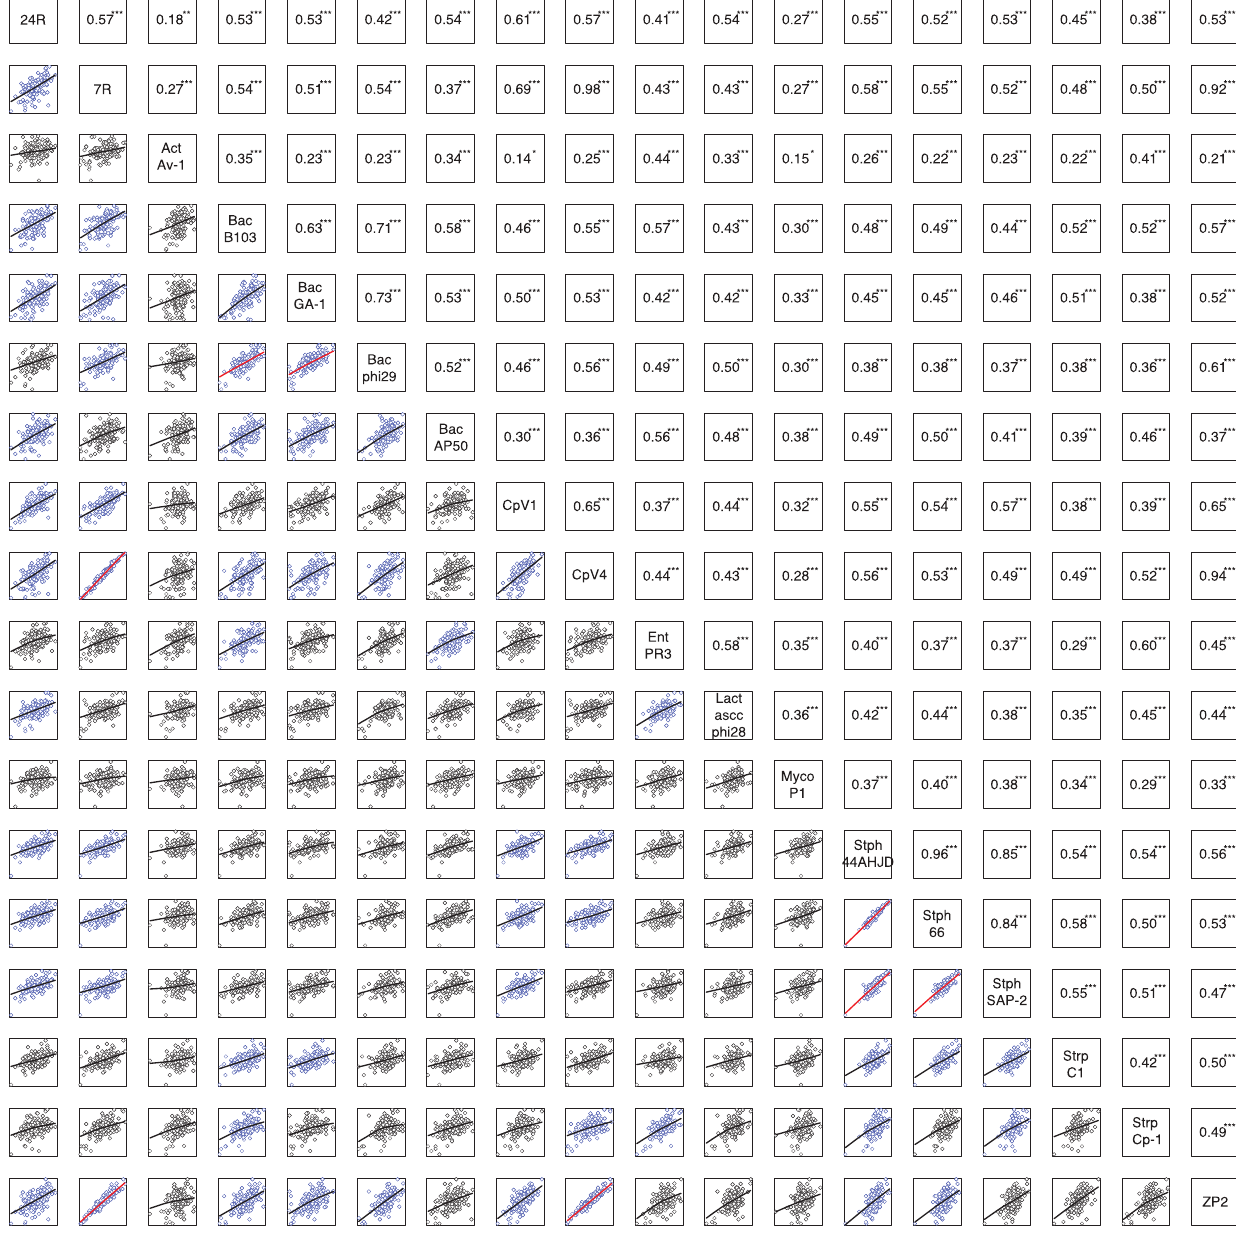
Figure 6. Whole-genome Tetra-nucleotide Frequency Comparisons Relative to Bacteriophages W CPV4, W ZP2 and W CP7R. Lower panel shows normalized frequencies of 256 tetranucleotides for each genome, upper panel shows Pearson correlation coefficients. In lower panel, the most closely-related genomes are shown in blue and red. Genome comparisons with correlation coefficients . 0.5 are shown with blue points, r- squared values from simple linear regression . 0.5 are shown with red lines. Genome names are shown on diagonal